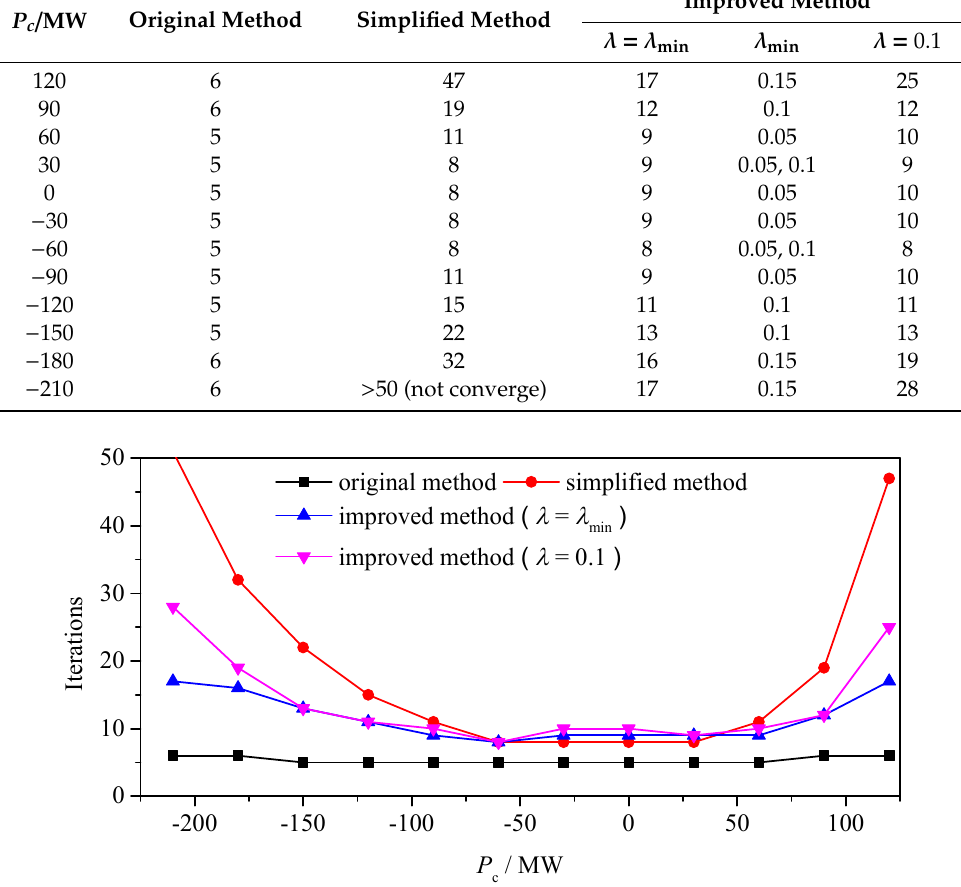
Figure 5. The comparison of iteration numbers under di ff erent P c.